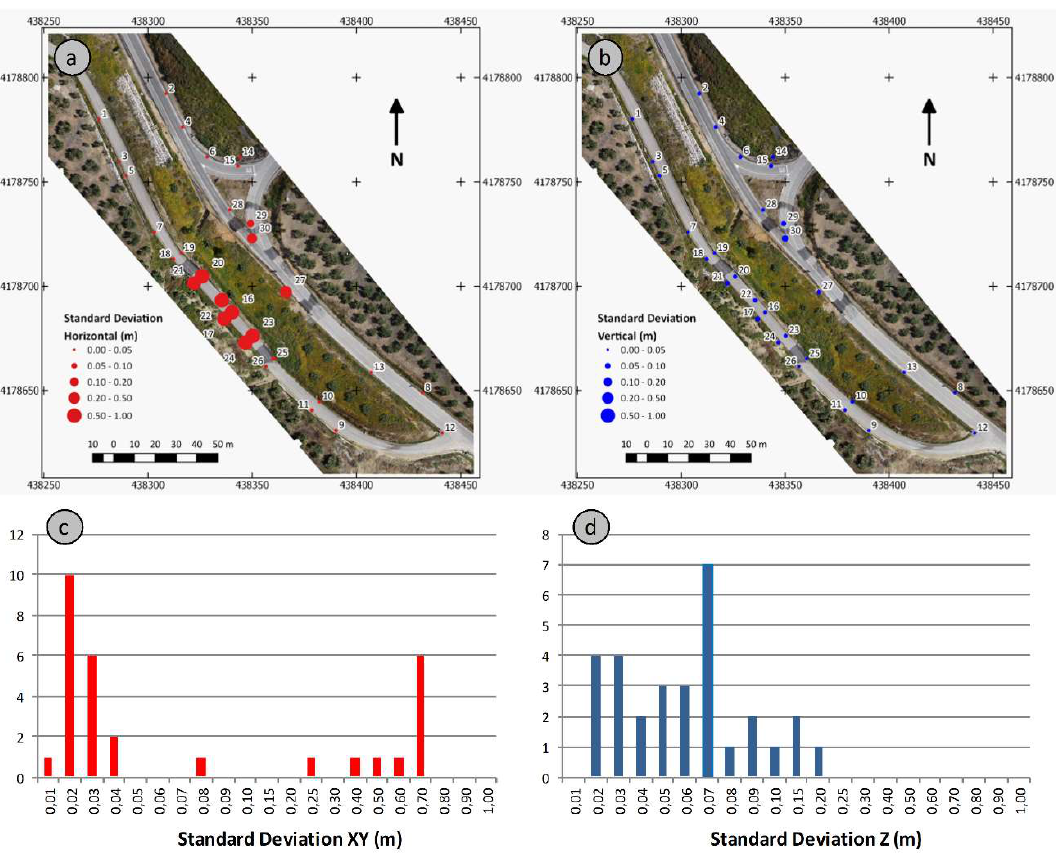
Figure 6. Standard deviation of monitoring points. Horizontal component: ( a ) Map; ( c ) Histogram; Vertical component: ( b ) Map; ( d ) Histogram. Both maps are based on the orthophotograph of 2013 / 05 / 03. Coordinates are in ETRS89-UTM-30N.